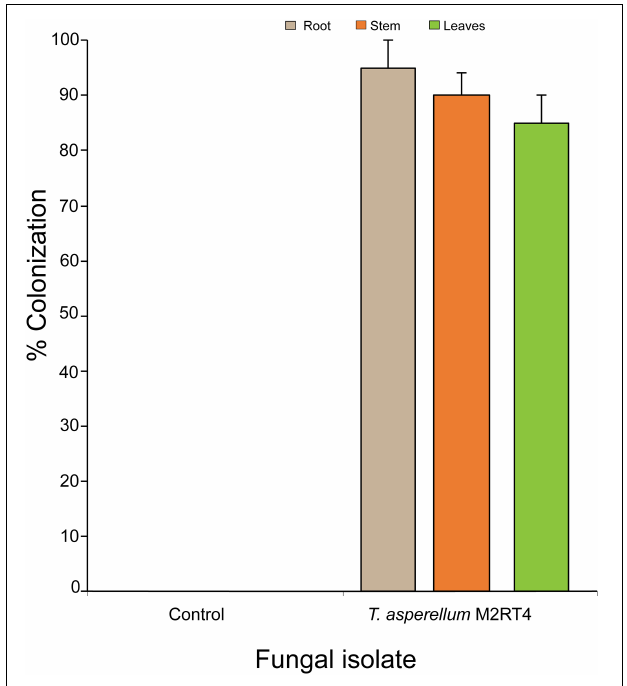
FIGURE 1 | Endophytic colonization of tomato Solanum lycopersicum host plant parts by Trichoderma asperellum M2RT4 at 4–5 weeks post-inoculation. Bar chart represents means ± SE (standard error) at 95% CI ( P < 0.05; n =